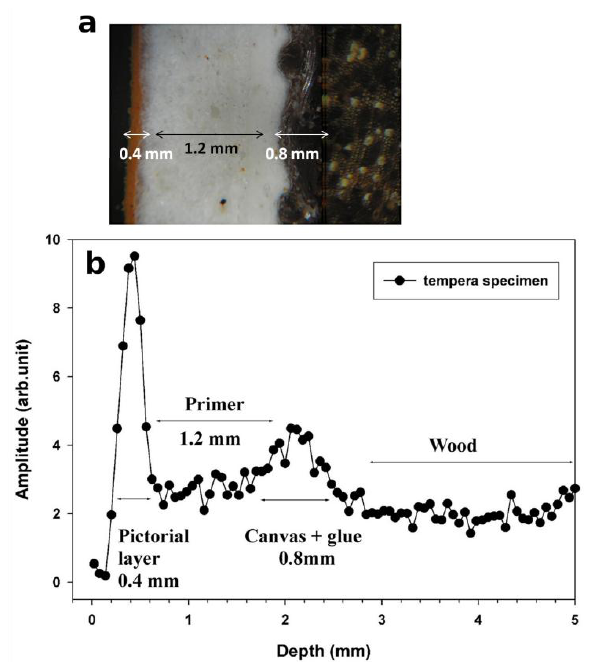
Figure 4. ( a ) Image across the painting layers obtained with an optical microscope on